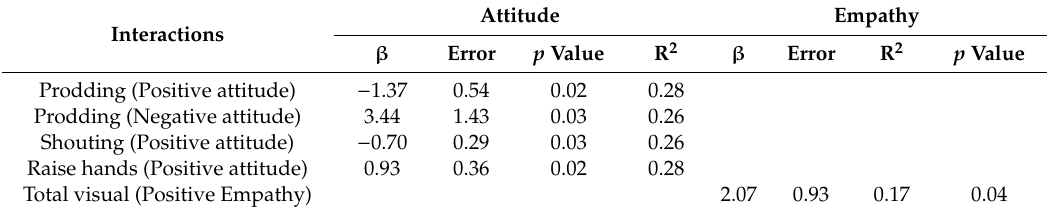
Table 6. Results from simple linear regression models of the relationship between handlers’ attitude and empathy scores with the interactions used during handling: Y = β 0 + β 1 Z i + ε i , where Y is